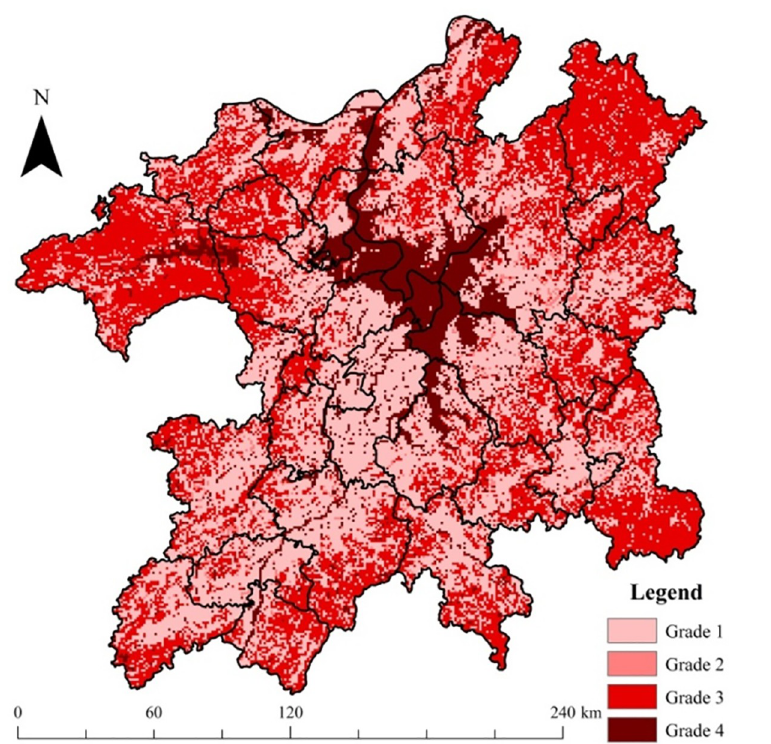
Fig 6. Grades of ecology function index in the